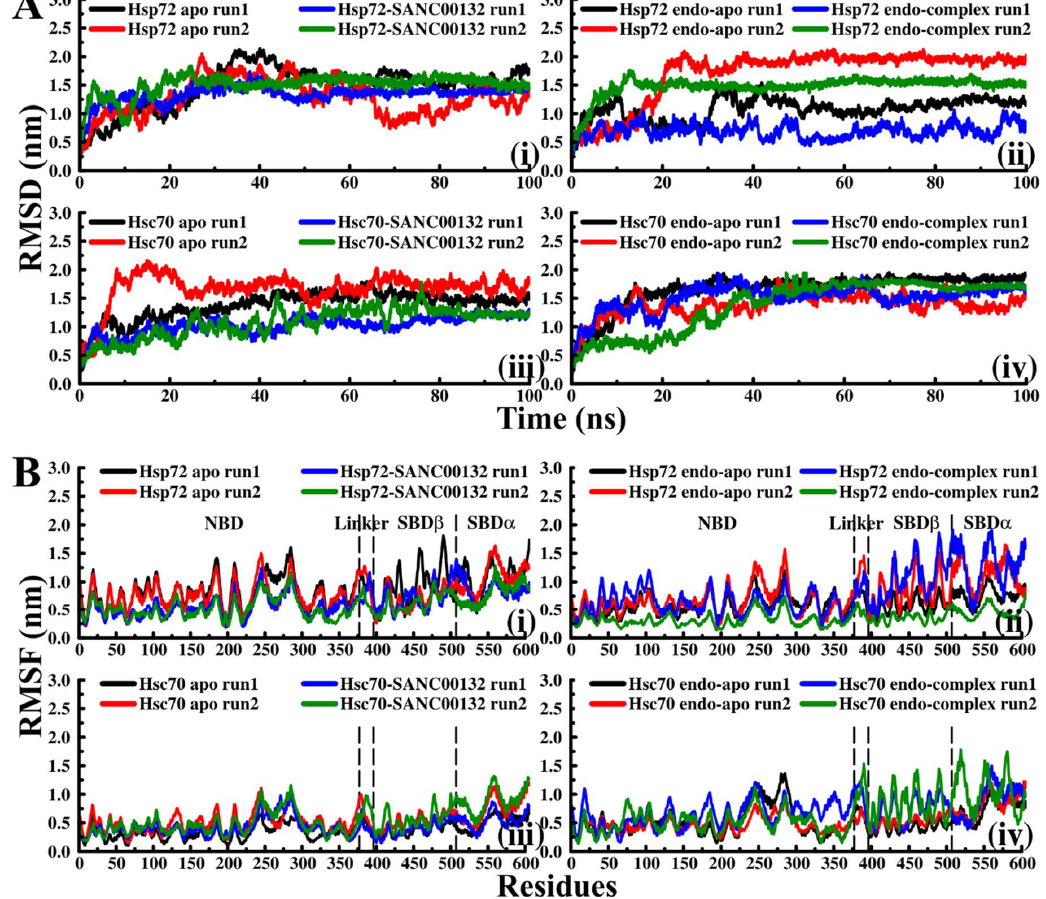
Figure 2. ( A ) RMSD evolution of back-bone atoms. ( B ) Average RMSF of residues computed from C α atoms. ( i ) Hsp72 Set1, ( ii ) Hsp72 Set2, ( iii ) Hsc70 Set1, ( iv ) Hsc70 Set2. Colour key: Black and red: SANC00132-free proteins. Blue and green: SANC00132-bound proteins.